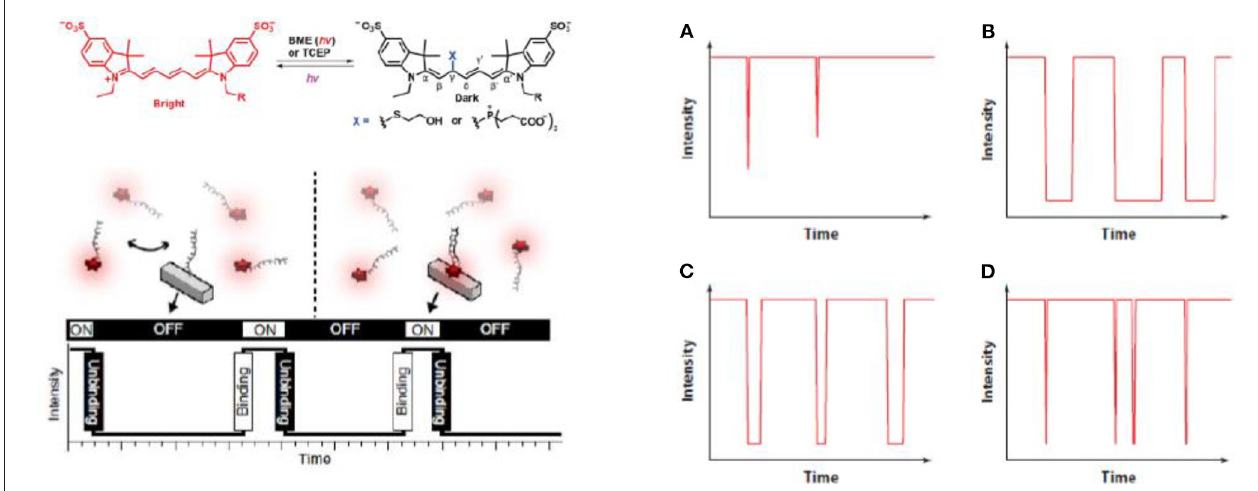
FIGURE 2 | Three typical methods to introduce single molecule blinking. A carefully designed buffer environment extends the length of the “OFF” state (van de Linde et al., 2011; Sauer and Heilemann, 2017; Li and Vaughan, 2018) (Top). In PAINT, blinking control is achieved by transient adsorption of the imaging strand to the binding strand immobilized on the substrate ( Jungmann et al., 2010; Stein et al., 2019) (Bottom). Triplet mediated blinking can be controlled in the gas phase without the use of solution environment once oxygen is removed and lifetime of triplet state extended (Ha and Tinnefeld, 2012; Blythe and Willets, 2016; Cheng et al., 2019) (Right). (A) Without oxygen removal. (B) Oxygen removed. (C) With an inefficient triplet quencher. (D) With an efficient triplet quencher. Copyright with permission from the American Chemical Society and Nature Publishing